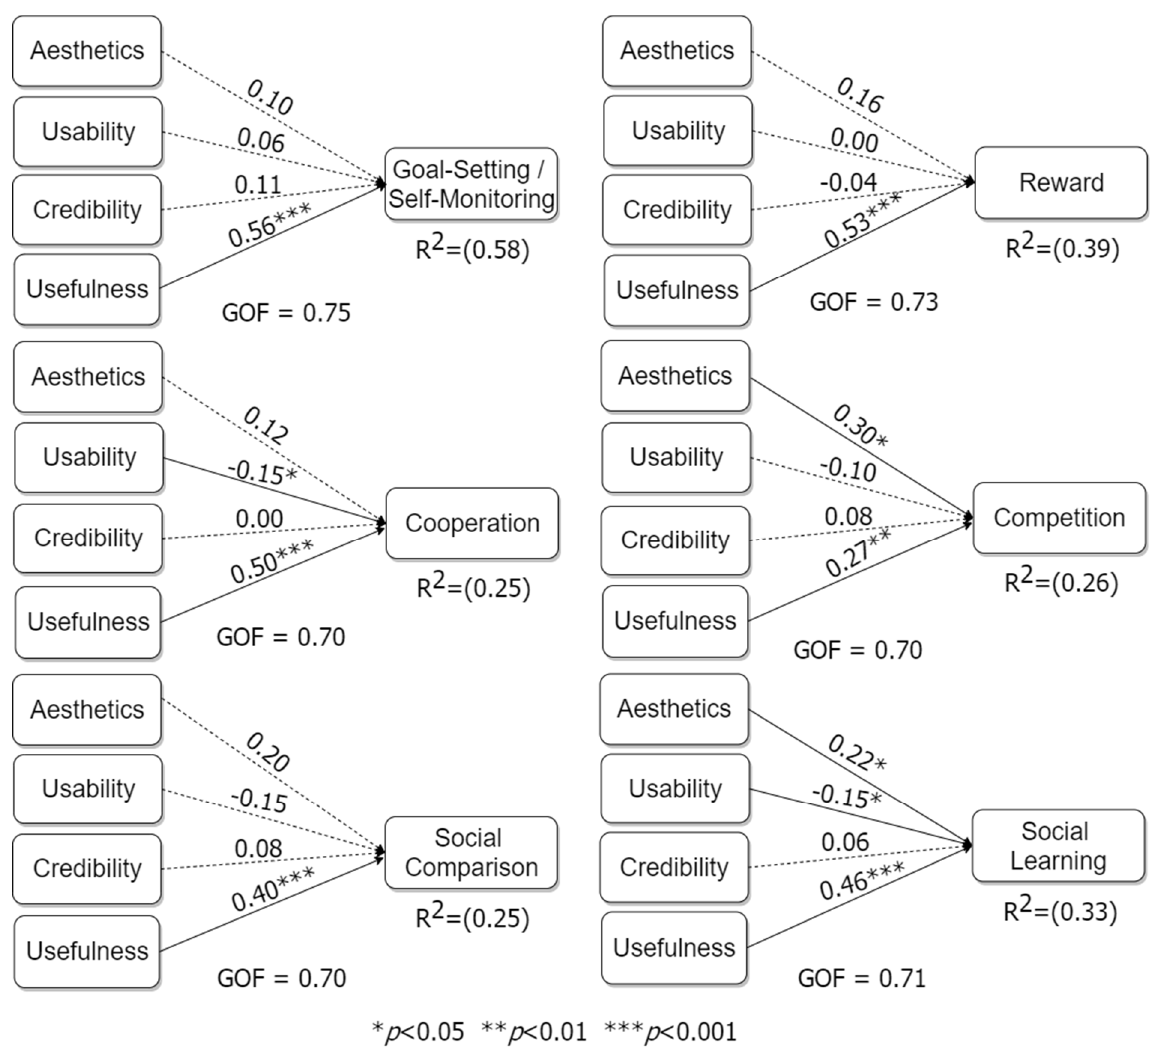
Figure 4. Models of the relationships between perceived UX design attributes and receptiveness to persuasive features.